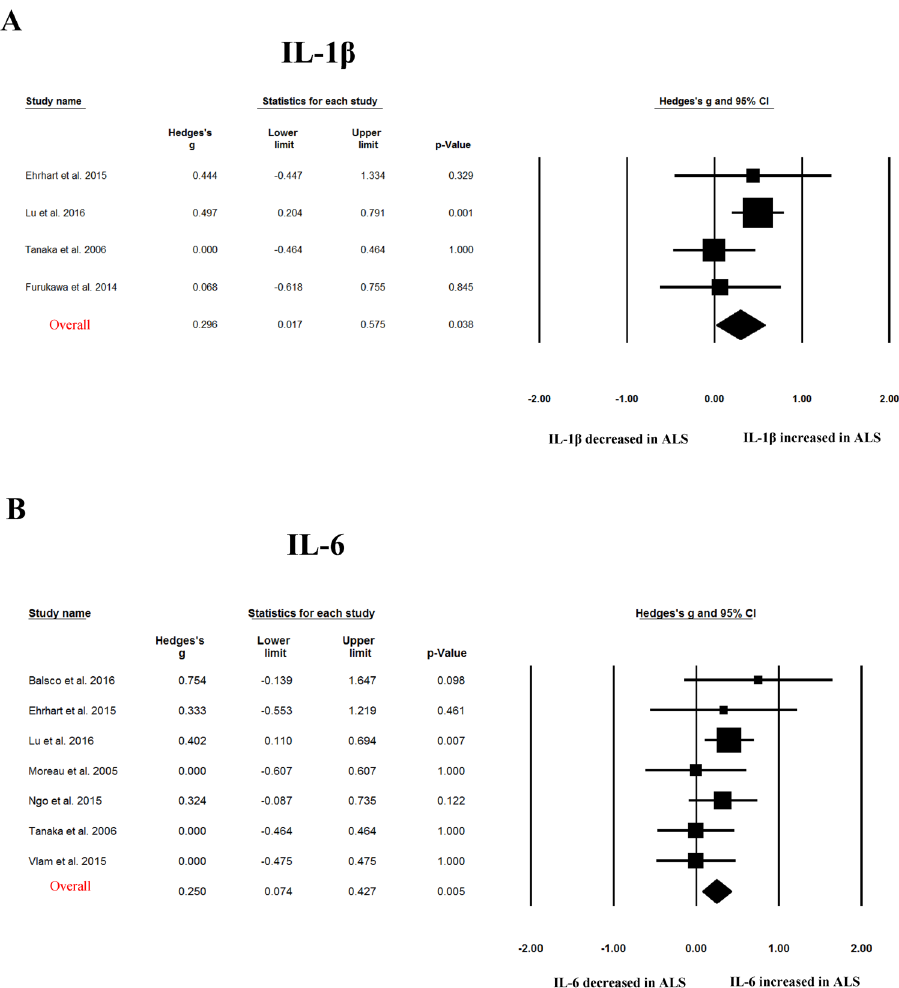
Figure 3. Studies of peripheral blood IL-1 β and IL-6. Forest plot displaying random effects meta-analysis results of the association between IL-1 β (A) , IL-6 (B) and ALS. The sizes of the squares are proportional to study